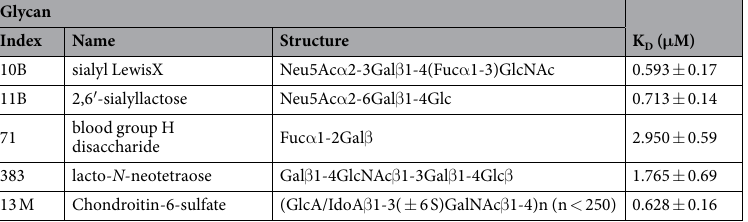
Table 2. ITC analysis of Opc-glycan interactions. Opc-glycan interactions were determined by comparison of outer membrane preparations from the Opc + Ȼ 4 and the Opc − Ȼ 11 strains (Table 1). Refer to Supplementary data S1 for sensorgrams for each individual experiment.